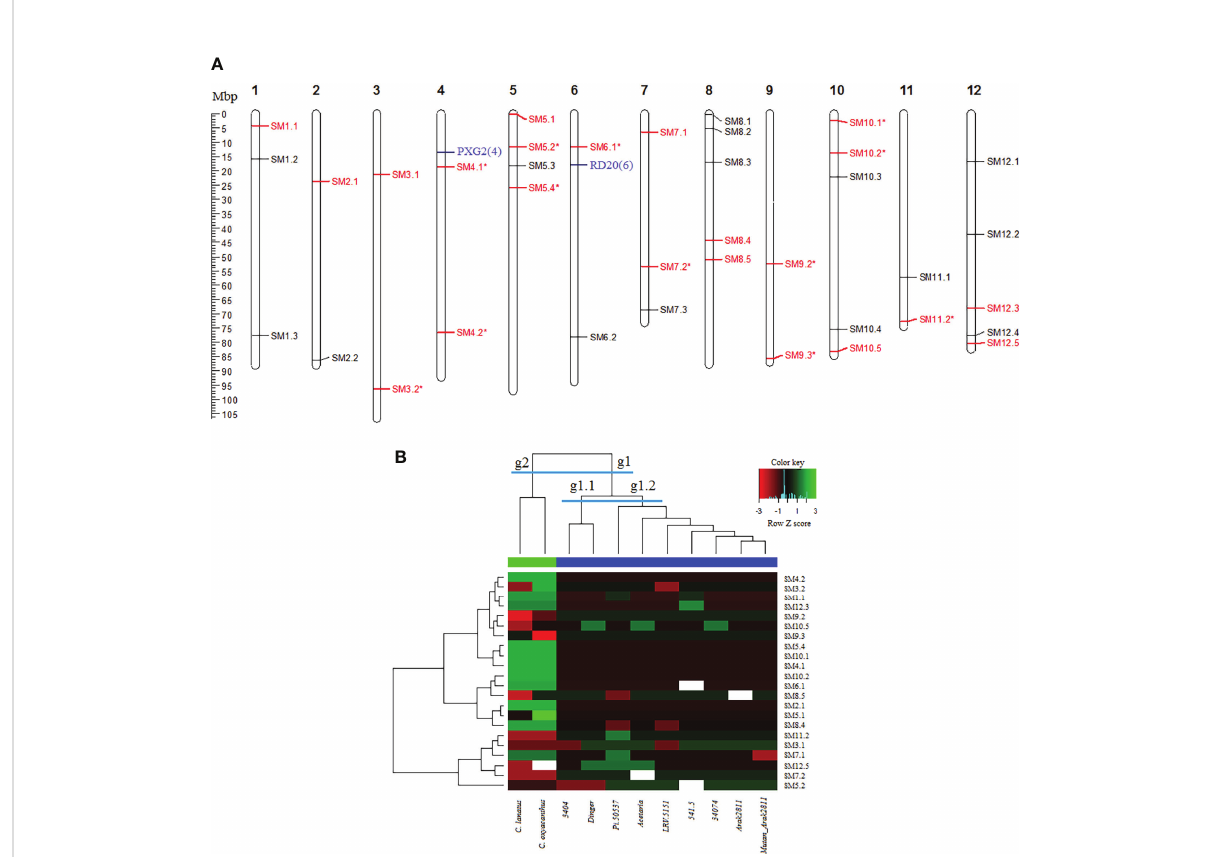
FIGURE 7 Analysis and validation of SSR markers in saf fl ower. (A) Physical map positions of 38 cDNA-SSR markers in saf fl ower genome. The map positions are in Mbp. The SSR marker names are presented on right-hand of each chromosome. Polymorphic markers are in red and the markers showing a monomorphic pattern among cultivated accessions are shown with an asterisk. Two key genes harboring trincleotide SSRs are shown in blue. (B) Grouping of the cultivated and wild relative accessions of saf fl ower by 22 polymorphic cDNA-SSR markers using two-sided clustering of heat map method. Two distinct groups are de fi ned: group g1 contains all cultivated accessions and group g2 contains 2 wild relatives ( C. lanatus and C. oxyacanthus ). The group g1 itself is clustered into two subgroups (subgroup g1.1 containing LRV-5151 and 34074, and subgroup g1.2 containing Arak 2811, mutant Arak 2811, Pi-50537, 3404, 541-5, Aceteria and Dinger). Green color: higher Z score values, red color: lower Z score